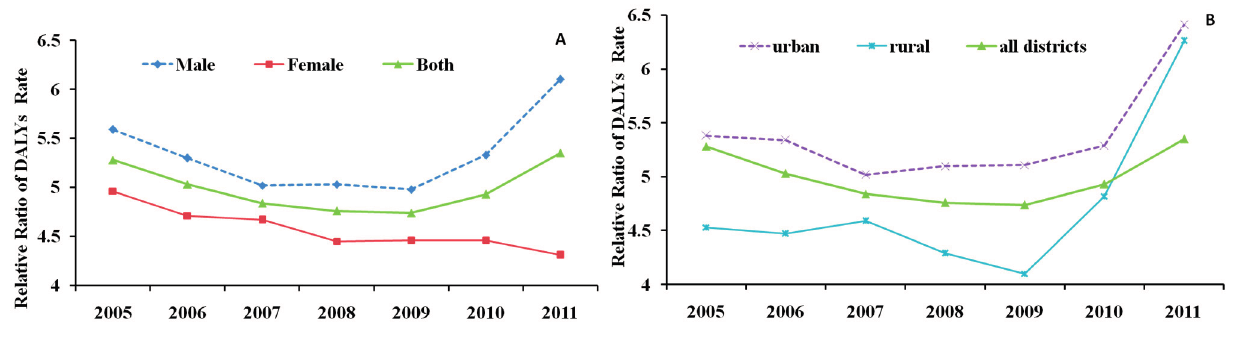
Figure 7. The change of RRs of DALYs rate by ( A ) sex and ( B ) district in China,